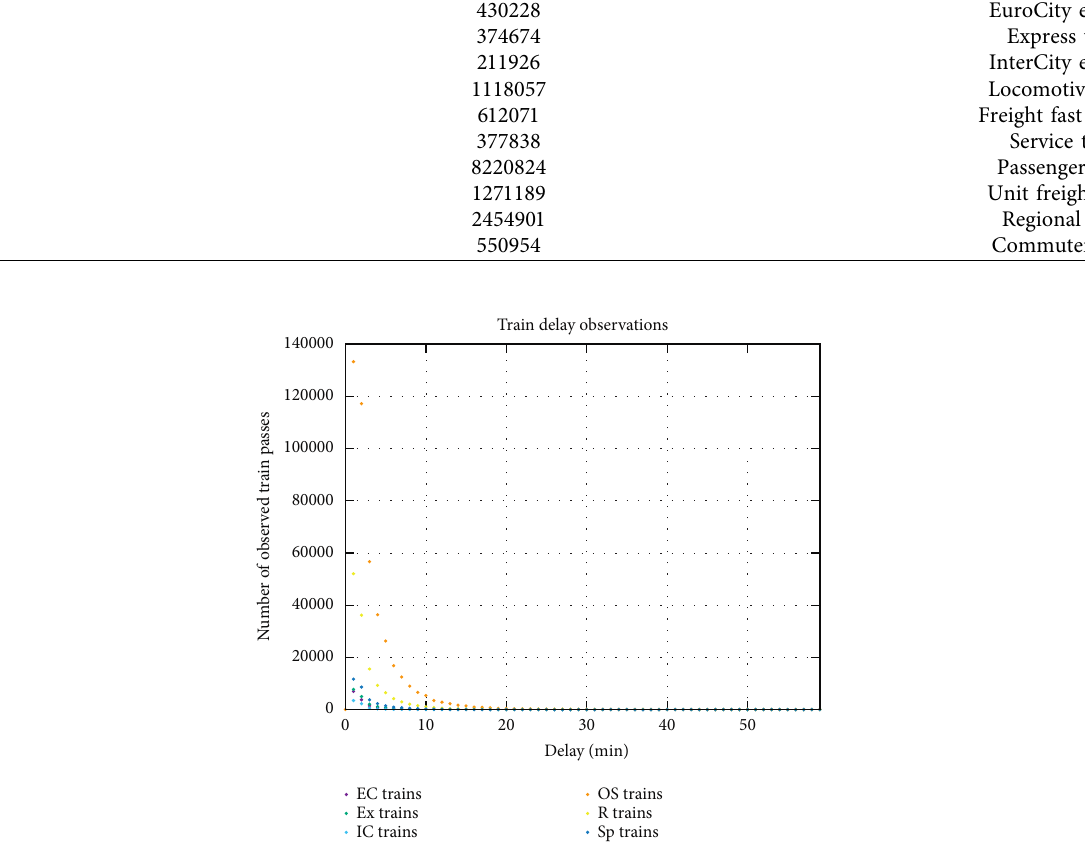
Figure 1: Example of train delay data histograms distinguished by train